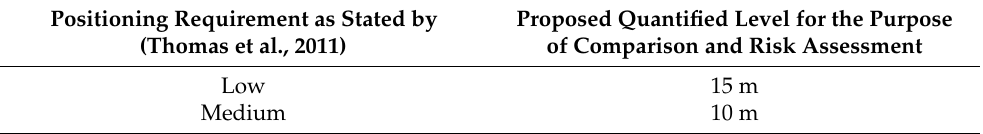
Table 2. Quantification of the qualitative GNSS positioning accuracy requirements outlined in [26]. Positioning Requirement as Stated by Proposed Quantified Level for the Purpose (Thomas et al., 2011) of Comparison and Risk Assessment Low 15 m Medium 10 m